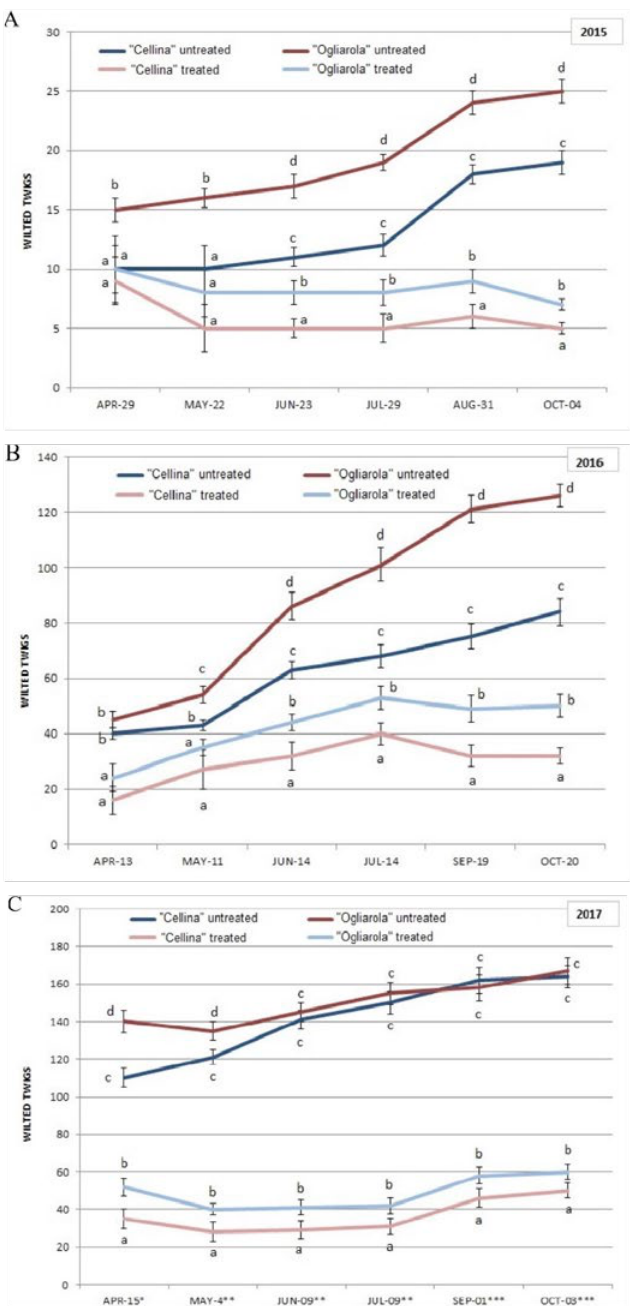
Figure 4. Mean numbers of wilted twigs on olive trees treated with Dentamet® during 2015 (A), 2016 (B) and 2017 (C), in an olive orchard located in Veglie (Lecce province) planted with cv. Ogliarola salentina and Cellina di Nardò and infected by Xylella fastidiosa subsp. pauca . Means were compared P <0.05. Bars represent standard deviations. Different letters indicate statistically significant differences. In the control block, trees began to die in December 2016. *: for control trees, data were for eight cv. Ogliarola salentina and ten cv. Cellina di Nardò trees. **: for control trees, data were for seven cv. Ogliarola salentina and seven cv. Cellina di Nardò trees. ***: for control trees, data were for cv. Ogliarola salentina and four cv. Cel - lina di Nardò